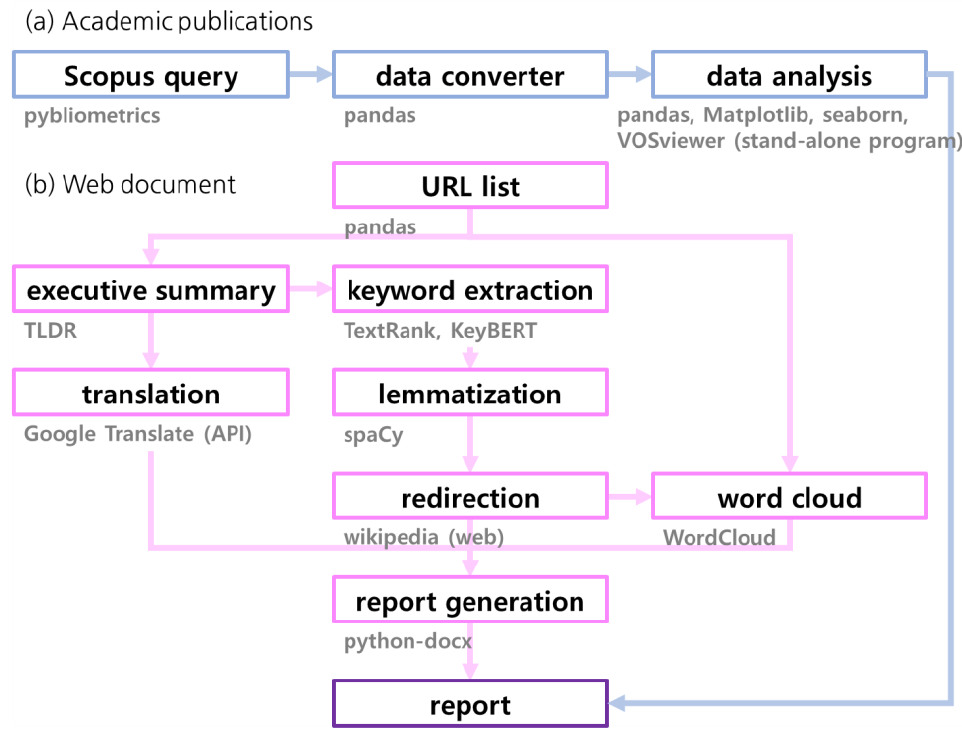
Figure 2. Schematic of the analysis of a foreign institution, ( a ) academic publications, and ( b ) web documents. Names of the Python packages and data analysis programs are annotated below each stage; the types of usage are parenthesized if not a Python package.